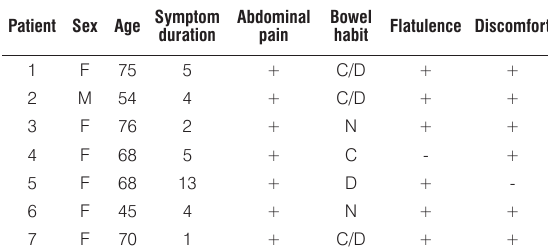
Table 1. Clinical characteristics of enrolled patients.